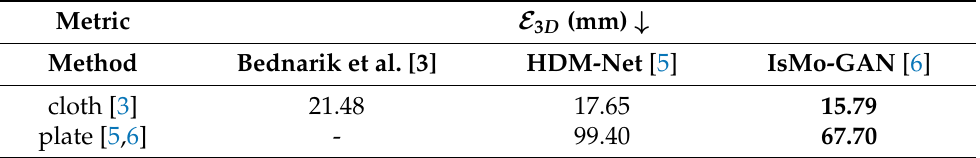
Table 6. Comparison of mesh reconstruction from textureless data. As can be seen, IsMo-GAN outperforms [3] and HDM-Net on the real textureless cloth data by 26.5% and 10.5% respectively, and it outperforms HDM-Net on the synthetic textureless thin-plate data by 31.9%. Bold values show the best results.